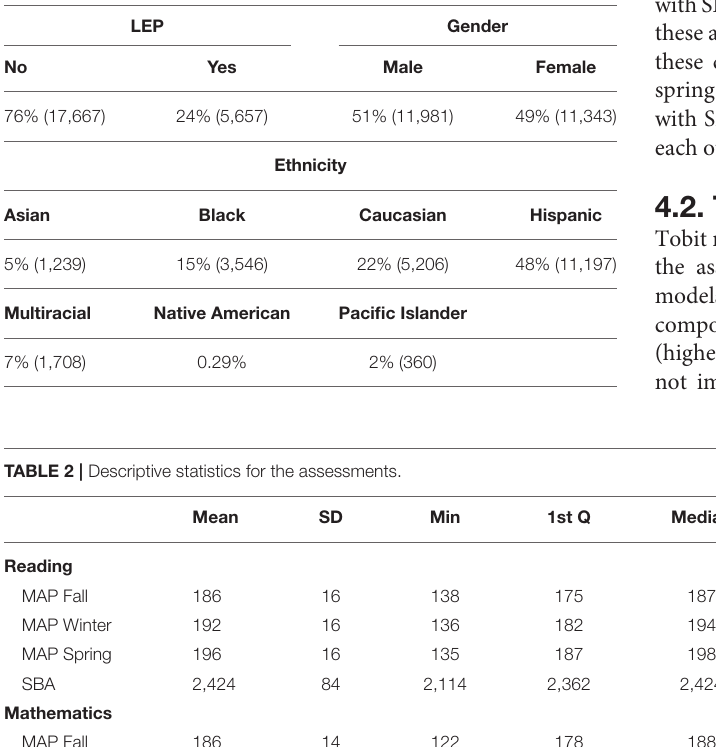
Table 1 . Ethnicity is divided into seven categories. The Pacific Islander and Native American categories have fewer people than